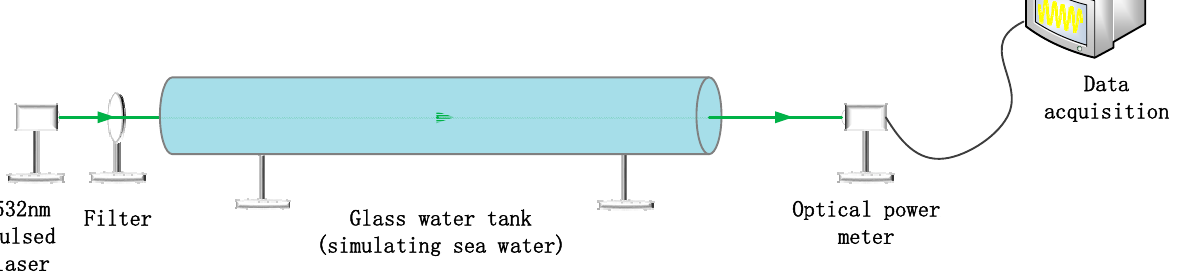
Figure 8. Schematic diagram of the experimental platform.